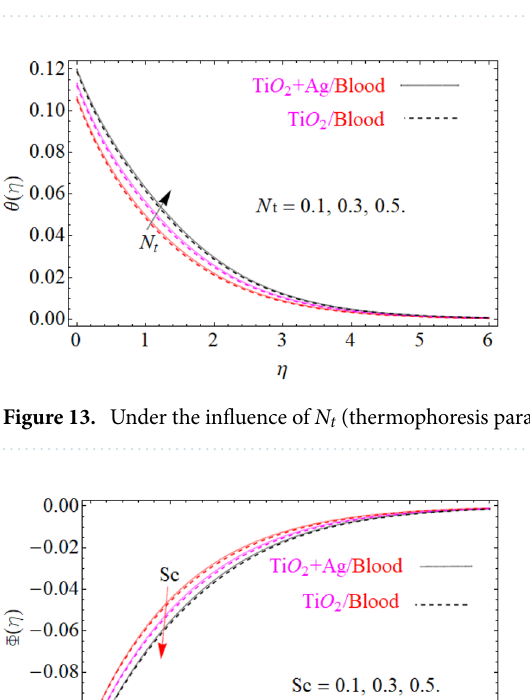
Figure 12. Under the influence of (φ 1 , φ 2 ) (nanoparticle concentration parameter), θ(η) .